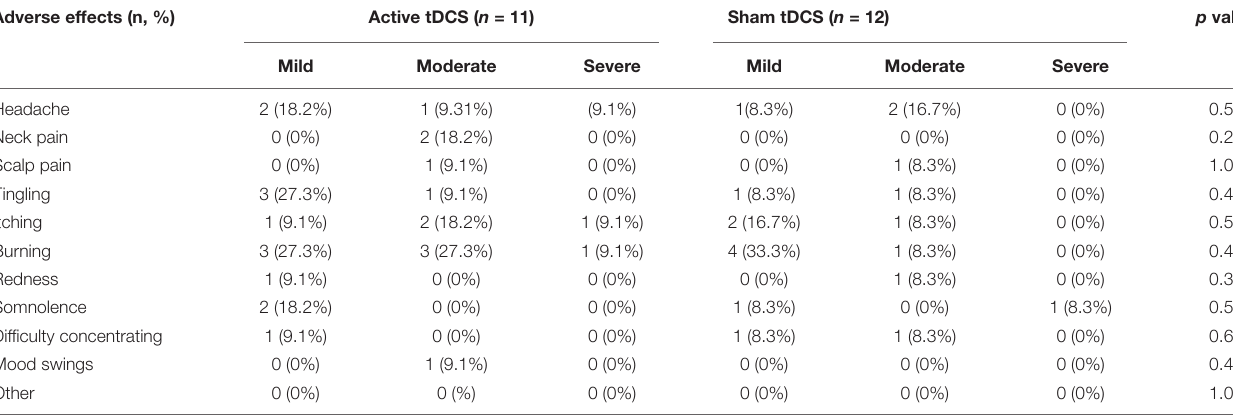
TABLE 6 | Adverse effects of using tDCS reported by active tDCS or Sham groups. Adverse effects (n, %)